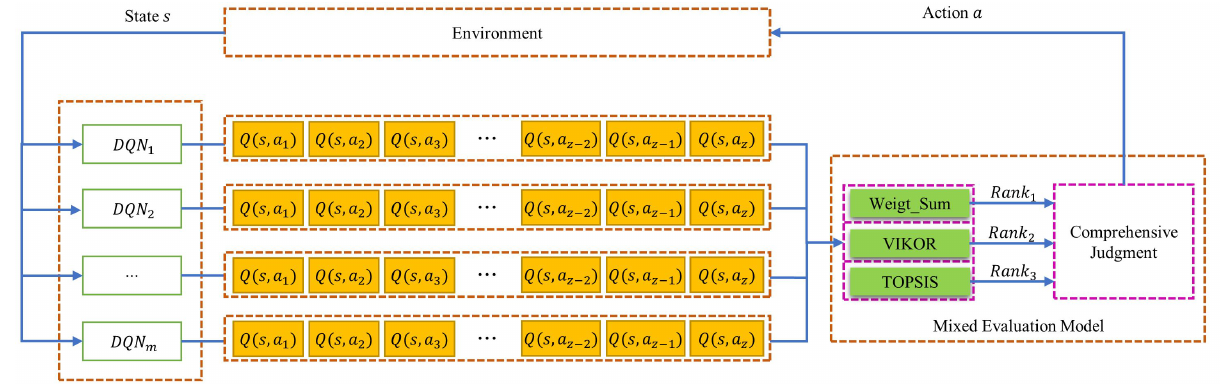
Figure 3. Action selection